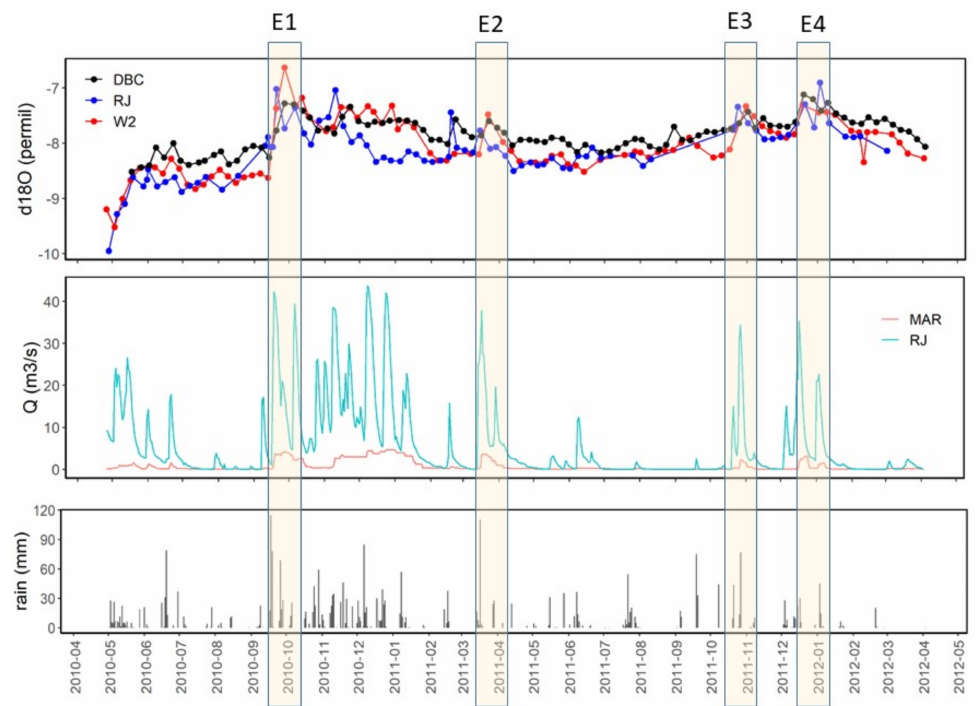
Figure 8. δ 18 O-time series of Rjeˇcina Spring (RJ), Martinš´cica well 2 (W2) and Dobrica (DBC), discharges for RJ and Martinš´cica discharge zone (MAR) and daily rainfall at CMHS meteorological station Kukuljanovo. E1–E4—isolated events in which the presence of newly infiltrated precipitation in the system was